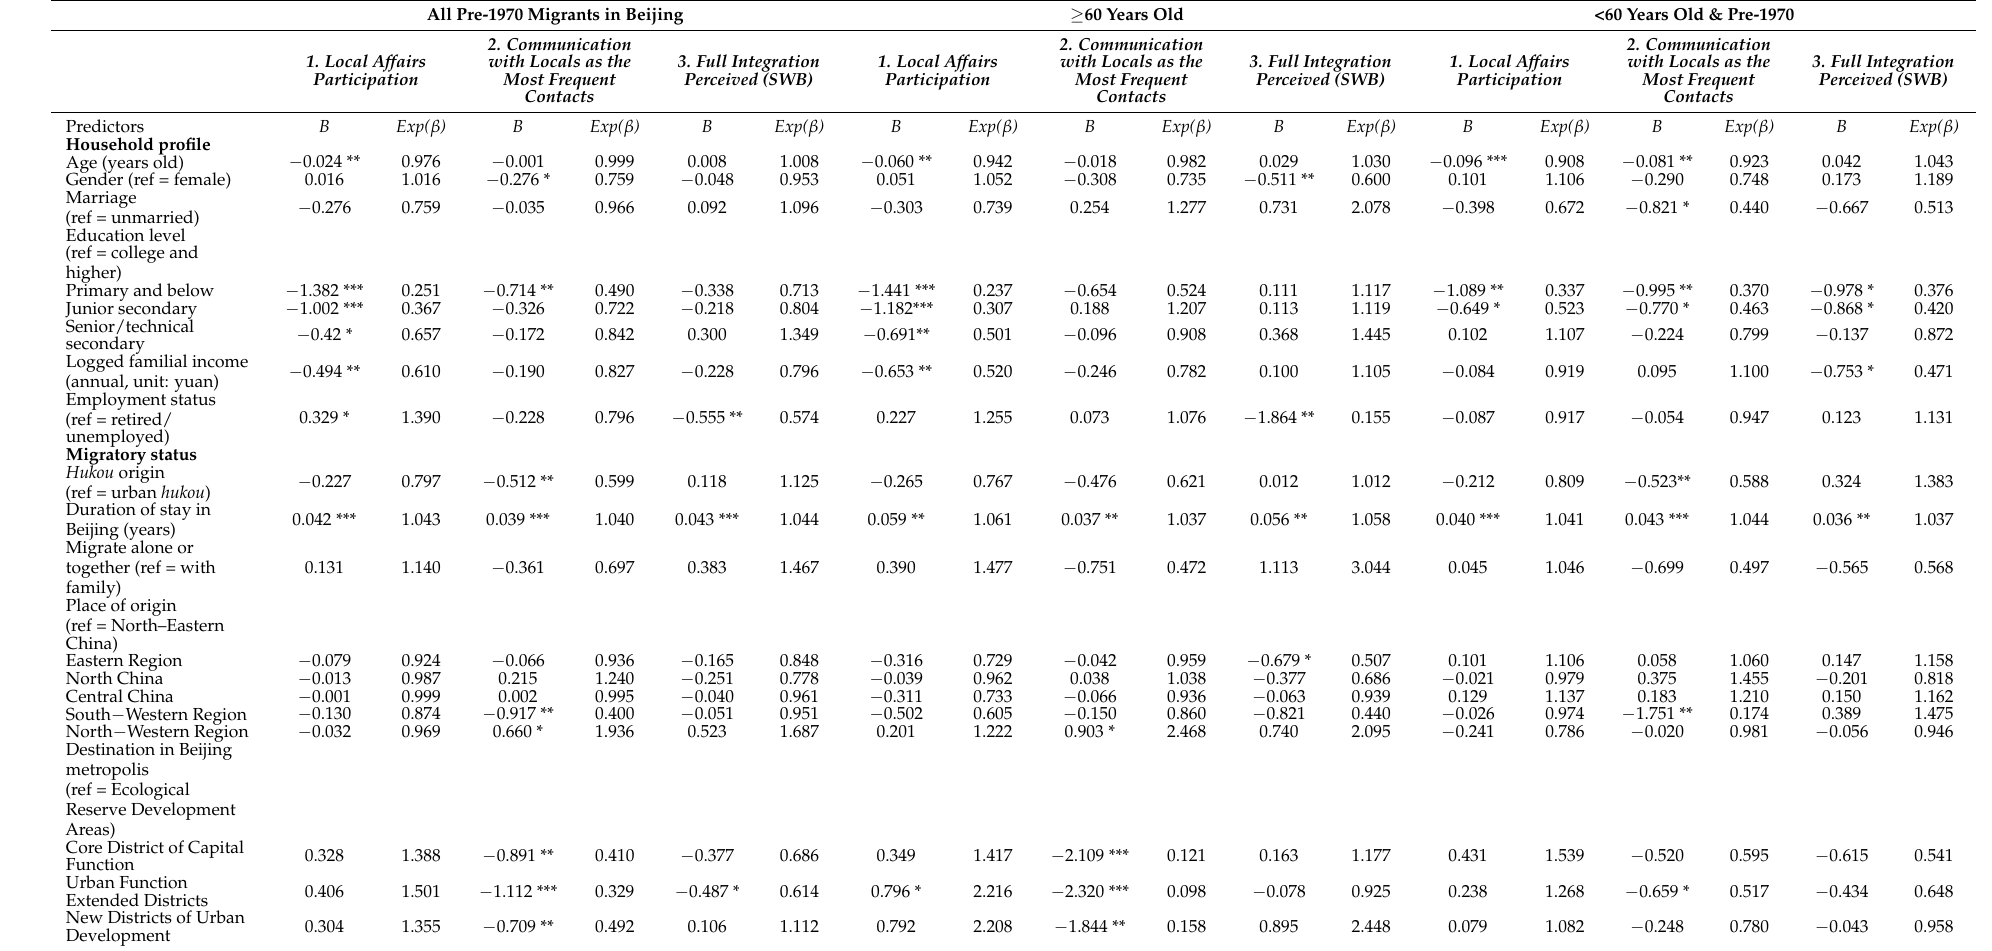
Table 3. Logistic regress on the pre-1970 migrants’ integration: (a) all pre-1970; (b) ≥ 60 years old; and (c) < 60 years old &